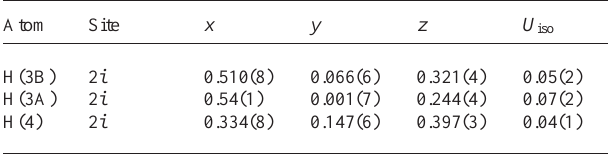
Table 2. Atomic coordinates and displacement parameters (in Å 2 ) .